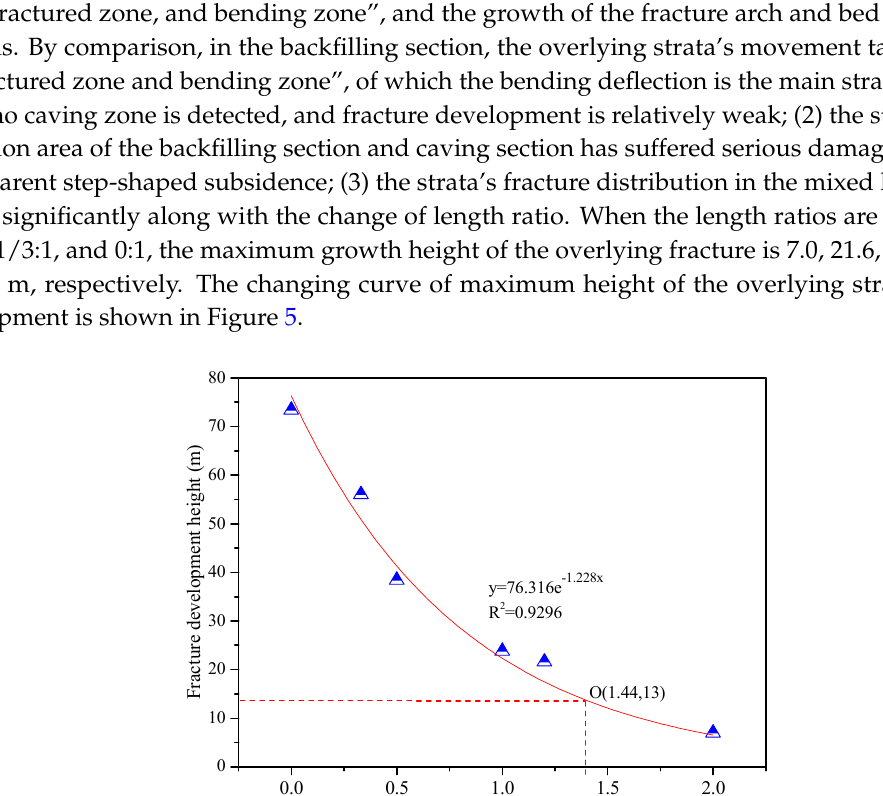
y=76.316e -1.228x